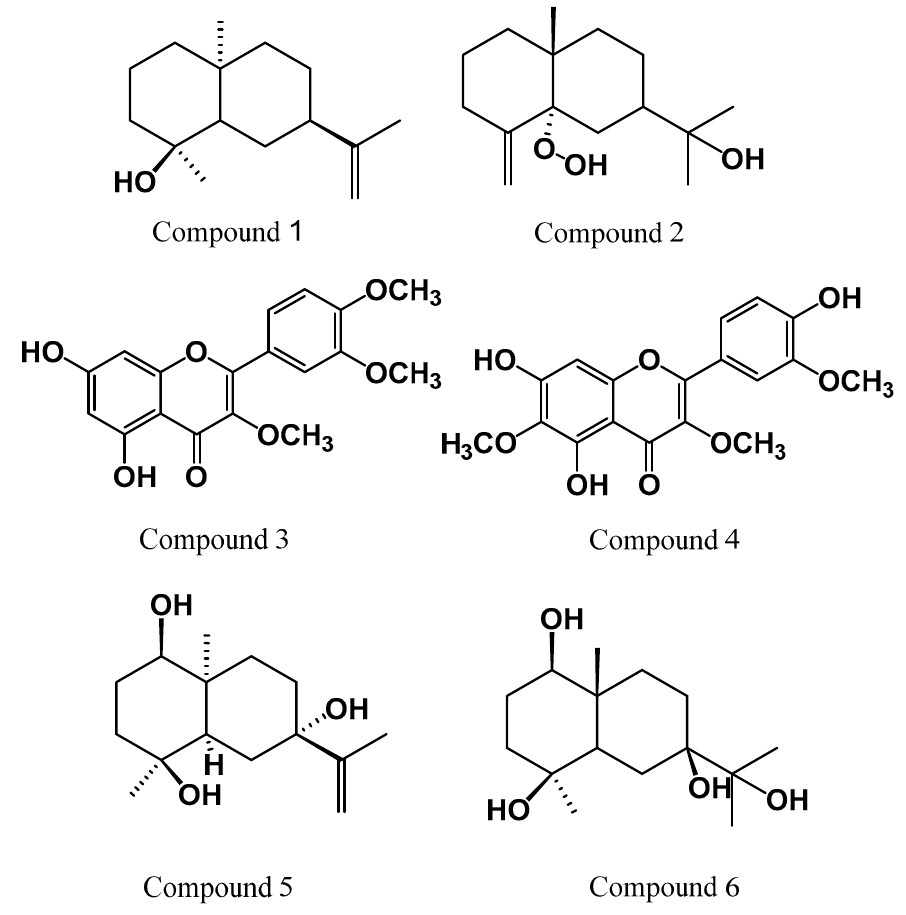
Figure 1. Chemical structures of the isolated compounds.